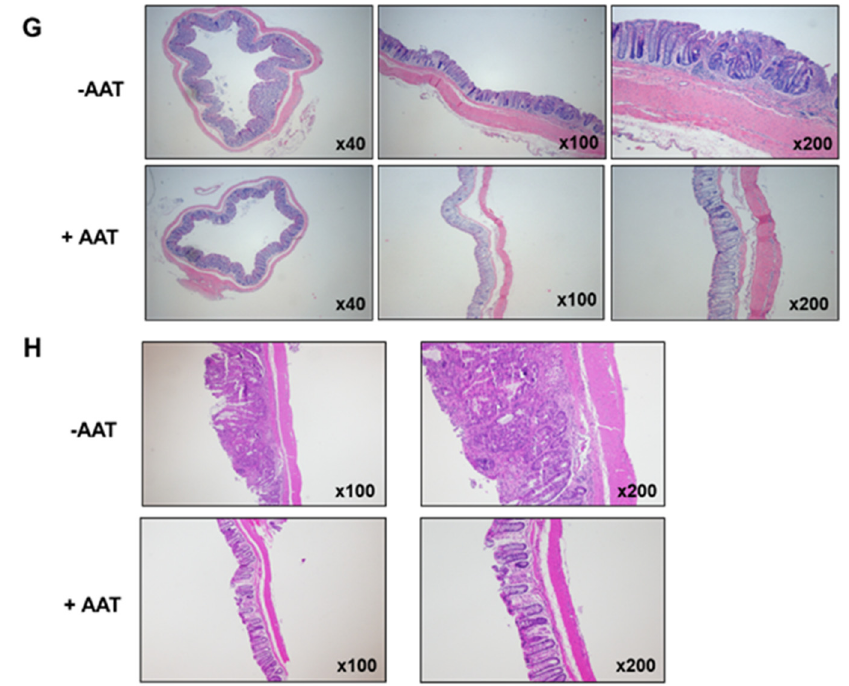
Figure 1. Preventive effects of AAT on CAC development. ( A ) Schematic overview of preventive protocol for AAT administration in AOM/DSS-treated mouse. Mice were injected with AOM (day 2 and day 65) followed by four cycles of 2.5% DSS in drinking water. 18 F-FDG PET/CT image and colon tumors were analyzed on day 91. ( B ) A representative 3D Maximum Intensity Projections of AOM/ 4cycle DSS (total 91 days) treated mice with/without AAT administration. Four regions within the yellow circle show high FDG uptake and are prominent in the colon of no AAT administration ( left ) while showing only one region with low FDG uptake in AAT administrated colon ( right ) in AOM/DSS-treated mouse. Gamma counting of the entire colon was 8.8% ID/g ( left ) and 5.6 %ID/g ( right ). FDG %ID/g = FDG uptake percent injected dose per gram of tissue. ( C ) Colons were removed and examined for macroscopic changes. Tumors were confined to the middle and distal colon. Tumor multiplicity ( D ), tumor distribution ( E ), and average tumor load ( F ) were determined. Results, mean ± SD [n = 6 ( − AAT), n = 7 (+AAT); **, p < 0.001]. ( G , H ) Anti-inflammatory and antitumor effects of AAT during initiation and progression of CAC were analyzed after treatment of AOM/ 2cycle DSS (total 47 days) ( G ) as well as AOM/ 4cycle DSS (total 91 days) ( H ). Colon tissue was further fixed and stained with hematoxylin/eosin. top, Control colon tissue without AAT treatment. Bottom, AAT treated colon tissue. In PBS-treated control colon tissue, the mucosa is expanded by glandular hyperplasia, mixed inflammation, and TIS formation. The submucosa is also expanded by inflammation. Original magnification, ×4, ×10 and ×20.